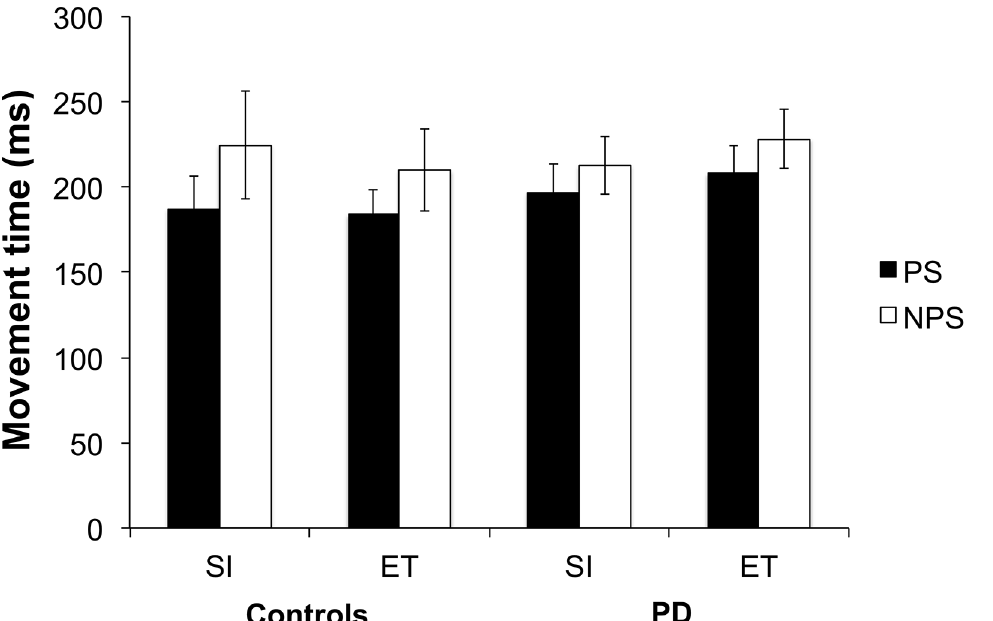
Fig 2. Movement time (ms) for controls and patients with Parkinson ’ s disease (PD) in self-initiated (SI) and externally-triggered (ET) conditions for the potential shock (PS) and no potential shock (NPS) trials.